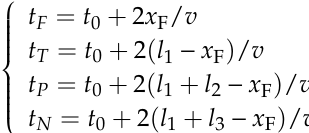
Table 2. Travelling wave types with their reach times.